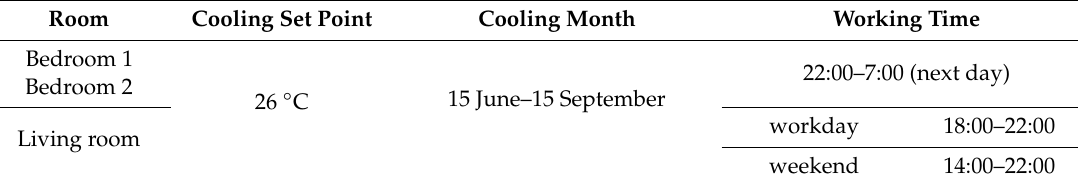
Figure 6. The layout of the apartment. (Data source: drawn by the authors). Table 7. Simulation parameters for cooling operation in the six cities.